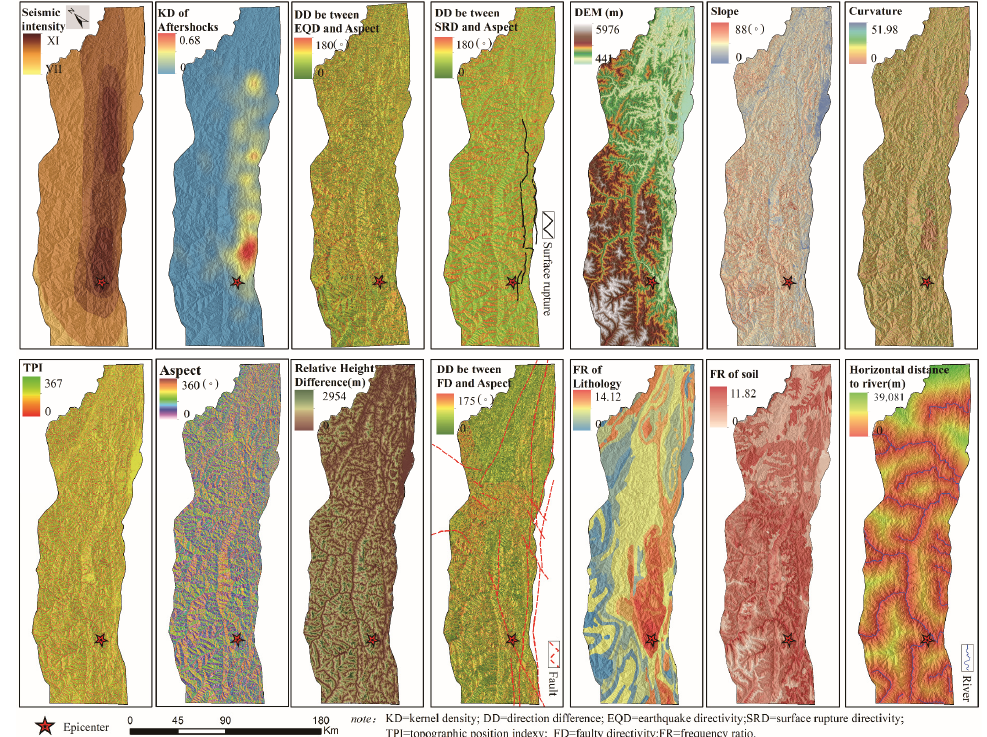
Figure 5. Controlling factors deduced from the seismic property, topography, geology, hydrology, and soil datasets.